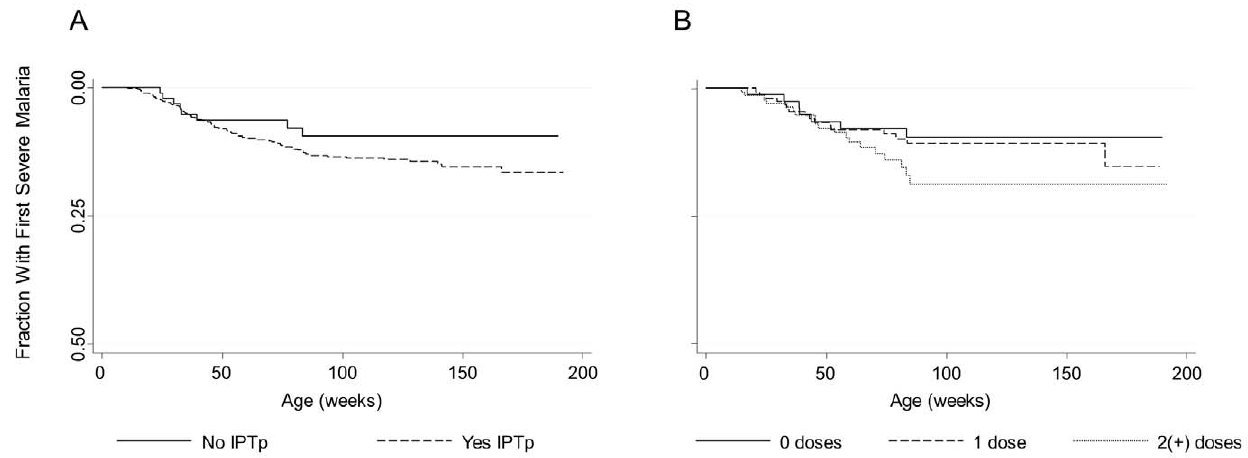
Figure 2. IPTp is associated with earlier first severe malaria episode. Kaplan-Meier curves of time to first severe malaria episode by maternal IPTp status (A) or dose (B). 1 dose: AHR=1.17, p=0.8 [95% CI: 0.45, 3.07]; 2( + ) doses: AHR=2.76, p=0.03 [95% CI: 1.11,